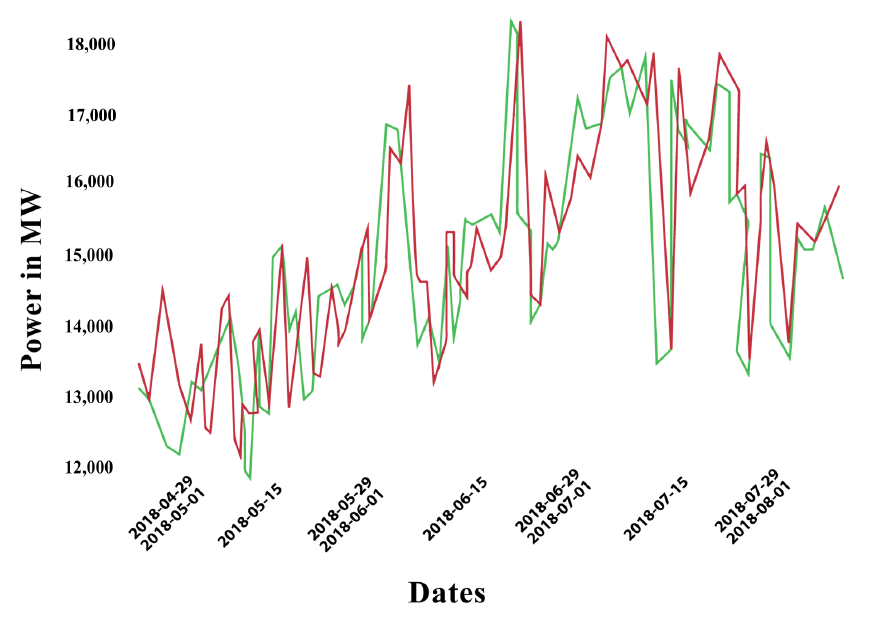
Figure 5. Real energy consumption versus predicted energy consumption for the 50th trading